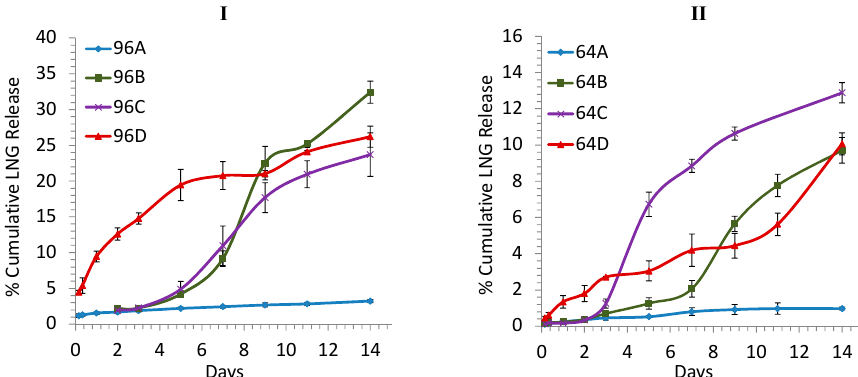
Figure 2. Short-term (accelerated) in vitro LNG release from formulations 96 ( I ) and 64 ( II ) at four accelerated conditions. (A) PBS, pH 7.4, 50 °C (filled diamond); (B) 25% ethanol in PBS, pH 7.4, 50 °C (filled square); (C) 25% ethanol in PBS, 2% Tween 20, pH 7.4, 50 °C (cross mark); (D) 25% ethanol in PBS, 2% Tween 20, pH 9, 50 °C (filled triangle). ( n = 3).